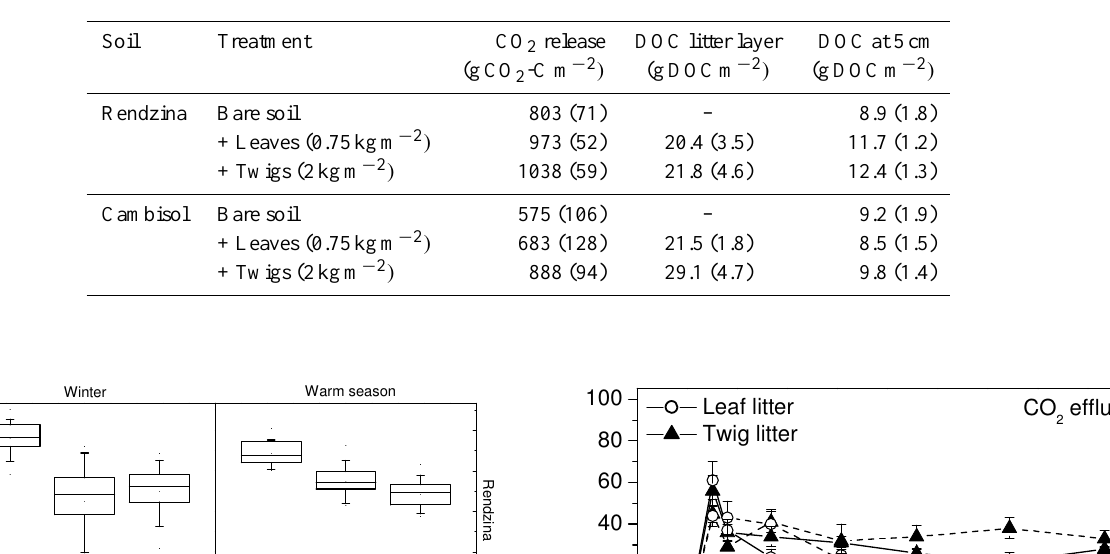
Table 3. Total C loss from forest soils through CO 2 and cumulated DOC fluxes below the litter layer and in the mineral soil at a depth of 5cm during the course of the litter experiment (November 2007–2008). The values are the means of five replicates ± standard errors.